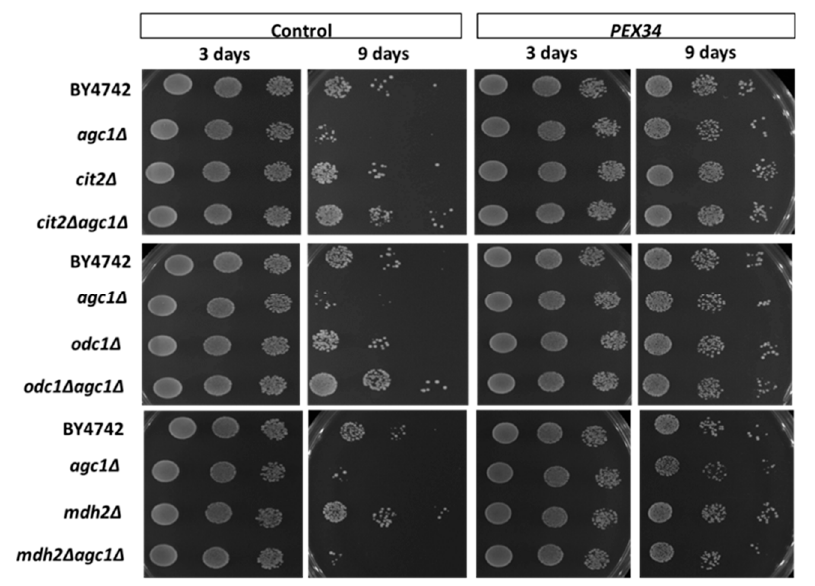
Figure 6. Activation of the malate–oxaloacetate NADH peroxisomal shuttle is sufficient for inducing longevity of agc1 Δ yeasts, but the malate–oxaloacetate NADH peroxisomal shuttle is NOT essential for PEX34 -mediated longevity in yeasts. Yeasts lacking genes disrupting the peroxisomal malate– oxaloacetate NADH shuttle ( CIT2 , ODC1 ) and genes required for this shuttle ( MDH2 ) were tested for cell viability during the stationary phase under PEX34 over-expression. The yeast array on an SD plate supplemented with 2% glucose indicated viability starting with 10 5 , 10 4 , and 10 3 cells.